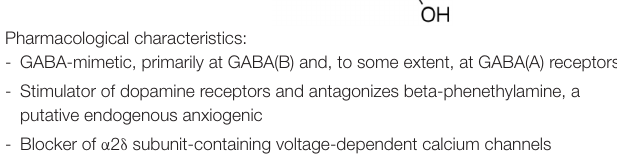
TABLE 1 | Phenibut: chemical and pharmacological characteristics. Phenibut, Anvifen, Fenibut, Noofen 4-Amino-3-phenyl-butyric acid Chemical structure: C 10 H 13 NO 2